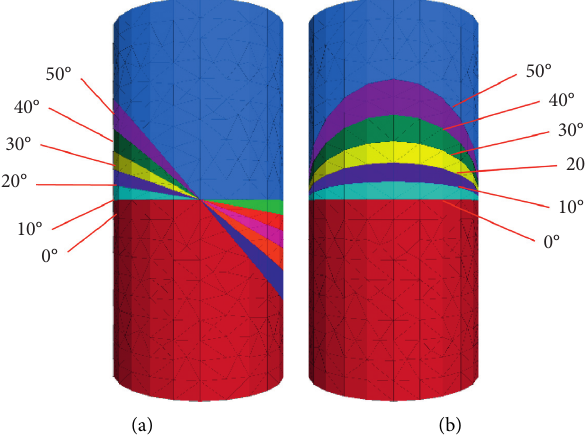
Figure 5: Joint angles considered in the rock specimen